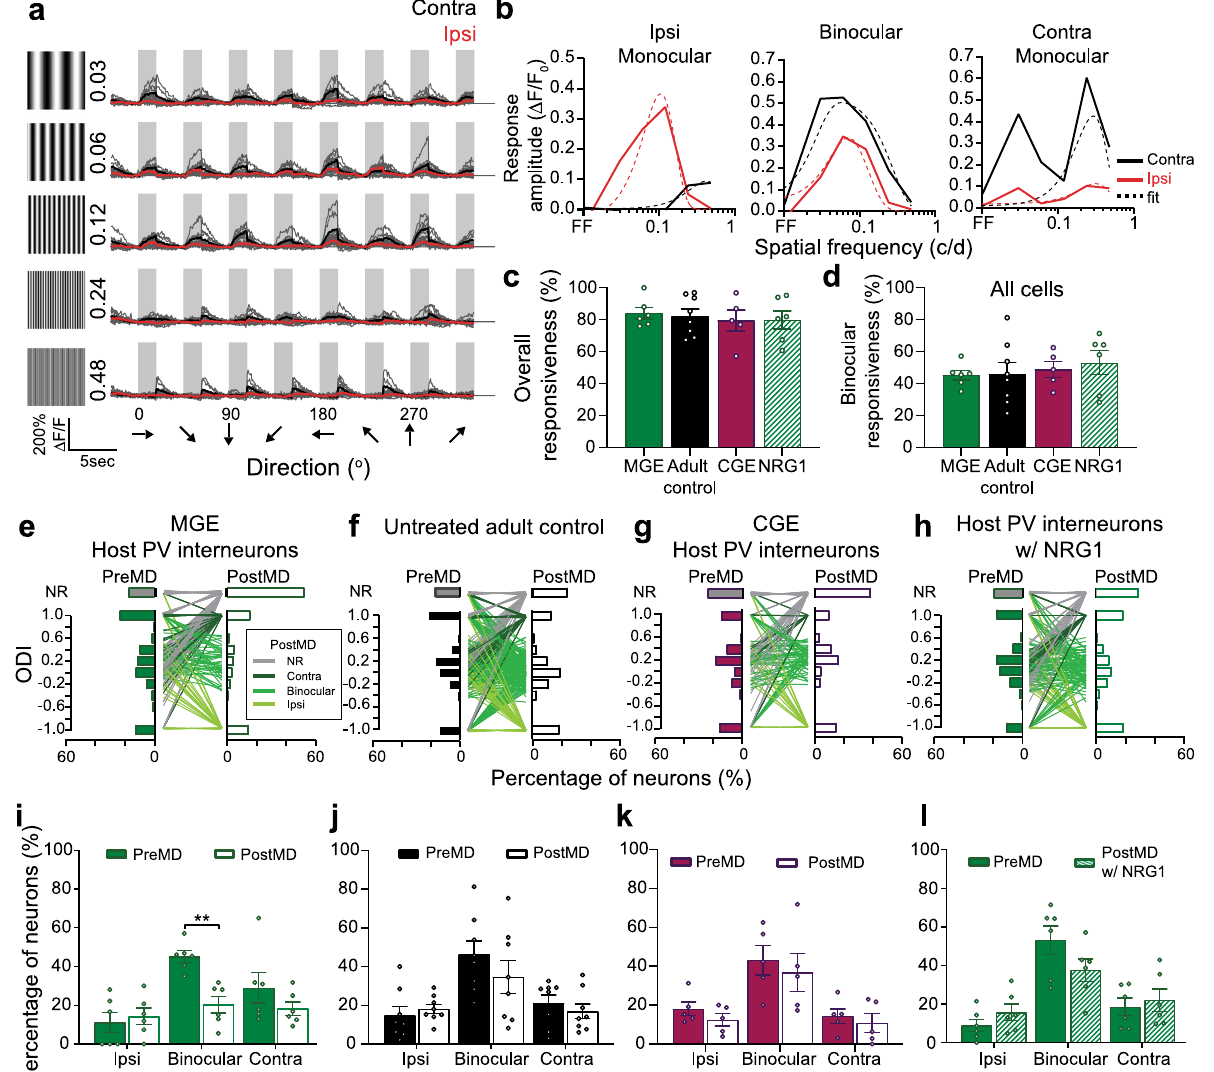
Fig. 5 NRG1 prevents the selective reduction of binocular responses in host PV interneurons. a , Example binocular responses from a host PV interneuron at 35DAT before MD. Gray boxes represent when the visual gratings were shown. Gray traces represent individual trials. Black represents averaged responses for contralateral eye stimulation. Red represents averaged responses for ipsilateral eye stimulation. The peak spatial frequency for the contralateral responses is 0.12 c/d and 0.06 c/d for the ipsilateral responses in the example shown. b Examples of different types of spatial frequency responses: binocular, contralateral monocular, and ipsilateral monocular cells. The average responses (solid line) at each spatial frequency are overlaid with a difference of Gaussians fi t (dashed line). c No difference found in the overall responsiveness between all four experimental groups (MGE: n = 6 mice, 84.14%±3.63, solid green; Adult control: n = 8 mice, 82.51%±4.33, black; CGE: n = 5 mice, 79.48%±6.57, magenta; NRG1: n = 6 mice, 79.99%±5.68, dashed green; p = 0.910, one-way ANOVA) before MD. d No difference found in the percentage of responsive binocular responses (MGE: n = 6 mice, 45.23%±3.00; adult control: n = 8 mice, 46.22%±6.99; CGE: n = 5 mice, 48.87%±5.00; NRG1: n = 6 mice, 53.11%±7.47; p = 0.816, one-way ANOVA). e – h Single-cell ODI distribution of PV interneurons before and after MD. The colors of the lines are determined by the cell ’ s PostMD ODI. Non-responsive cells (NR): gray; contralateral only cells: dark green; binocular cells: medium green; ipsilateral cells: light green. e 35DAT host PV interneurons with MGE transplant ( n = 260 cells from 6 mice). f Untreated adult PV interneurons ( n = 435 cells from 8 mice). g 35DAT host PV interneurons with CGE transplant ( n = 150 cells from 5 mice). h 35DAT host PV interneurons treated with NRG1 ( n = 248 cells from 6 mice). i – l Same data as e – h but plotted by animal. i 1D MD selectively reduced the percentage of responsive binocular PV interneurons ( n = 6 mice, ** p = 0.0018, two-way ANOVA followed by Bonferroni ’ s multiple comparison test). j No signi fi cant reduction in the percentage of responsive binocular PV interneurons after 1D MD in untreated, age-matched adult control ( n = 8 mice, two-way ANOVA followed by Bonferroni ’ s multiple comparison test). k No signi fi cant reduction in the binocular host PV interneurons in adults with CGE transplant ( n = 5 mice, two-way ANOVA followed by Bonferroni ’ s multiple comparison test). l NRG1 treatment prevented the reduction in responsiveness of binocular PV interneurons after MD ( n = 6 mice, two-way ANOVA followed by Bonferroni ’ s multiple comparison test). Data in c , d , i , j , k , and l are Our results are surprising because they counter the prevailing reorganization that depends on the function of ErbB4 receptors idea that transplanted interneurons play a direct role in gating the on host PV interneurons (Fig. 7). Taken together, these results plasticity of the host circuitry. Even though the transplanted PV suggest that transplanted cells modify host interneurons to create interneurons show normal receptive fi eld properties and proper a new critical period for synaptic plasticity.